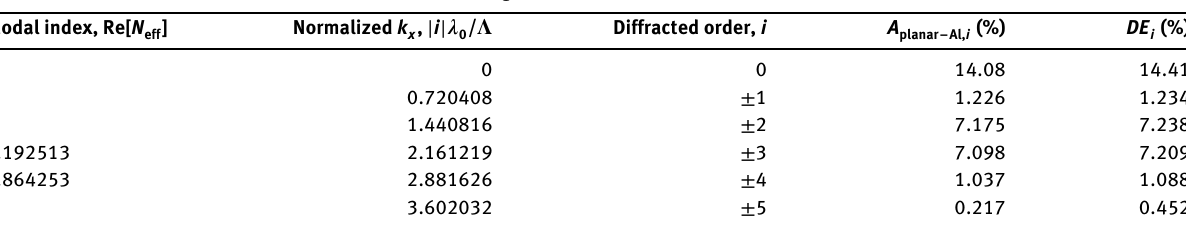
Table 2: Comparison of normalized parallel wave vectors k x ∕ k 0 associated with the first six diffracted orders and modal indexes of the supermodes sustained by a 2D slice through the centers of square prisms 3 and 4 at 𝜆 0 = 627 nm. The corresponding effective strip widths are 100 and 242.77 nm,